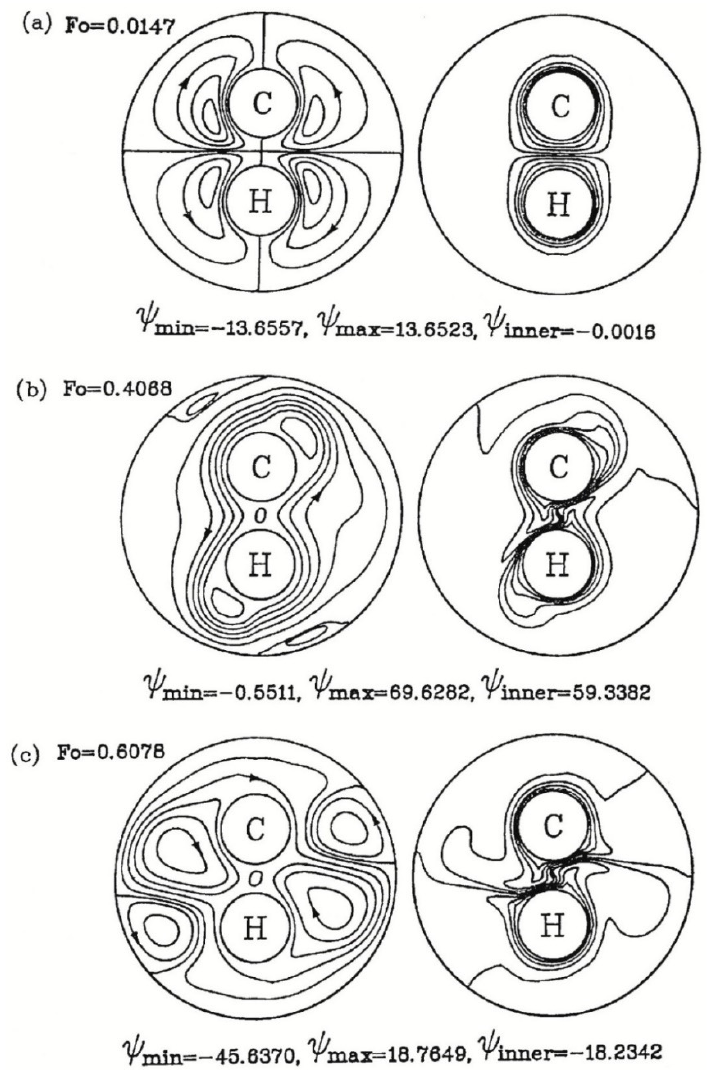
Figure 6. Transient variations in flow pattern ( right ) and temperature field ( left ) ( φ g = − 90 ◦ , Ra = 10 5 and s/d = 0.7).